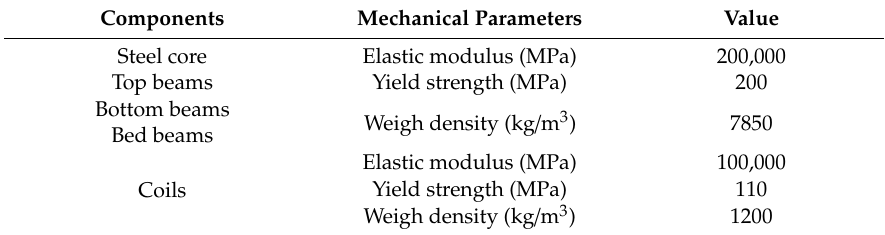
Figure 3. Complete analytical model used in analysis program. Table 2. Mechanical parameters of the mold transformer.